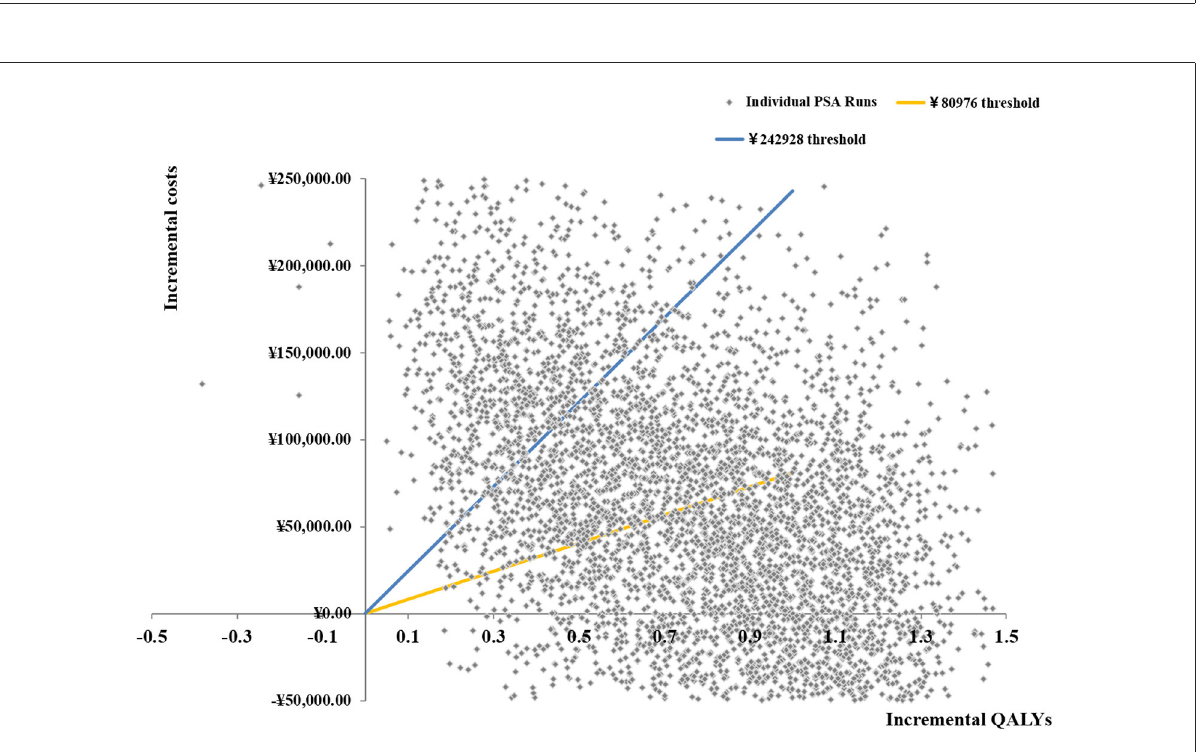
FIGURE4 Base-case probabilistic sensitivity analysis: scatter plot (5,000